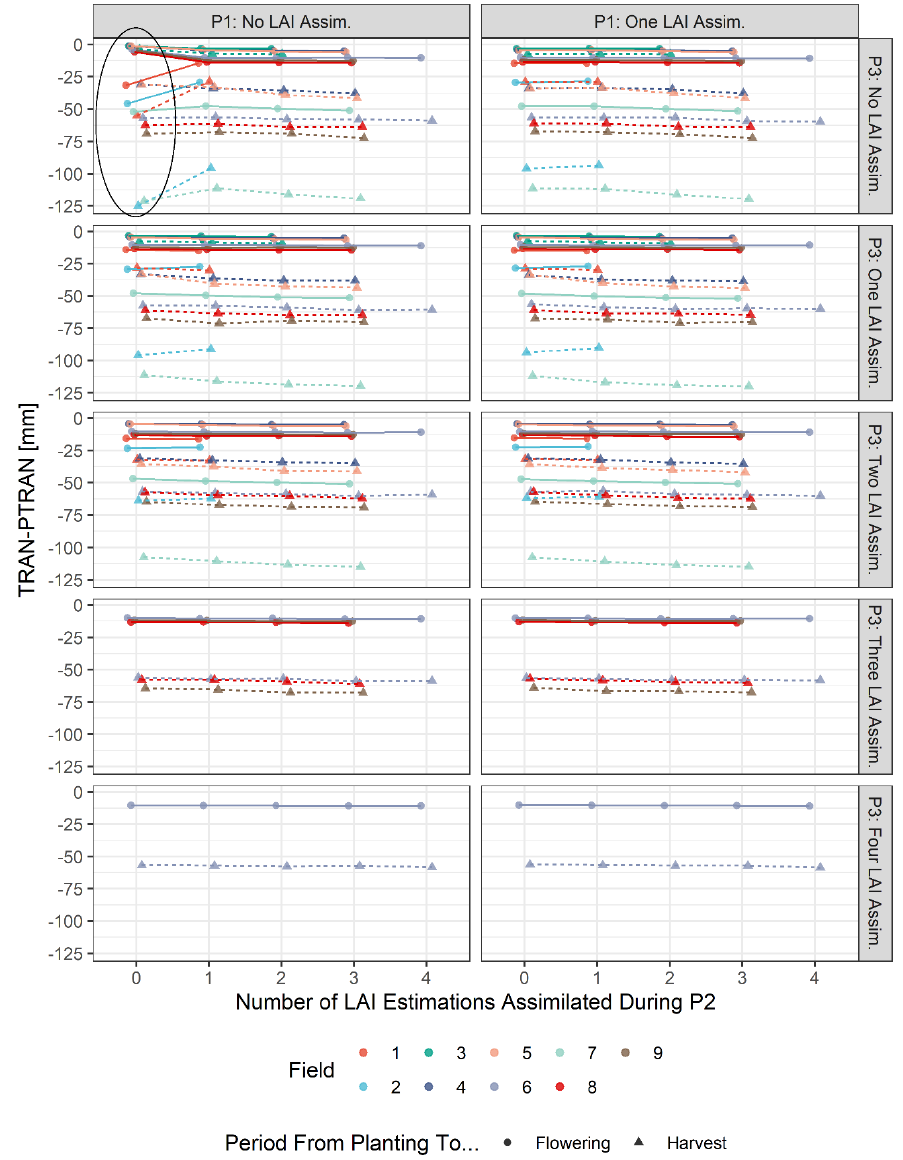
Figure 3. Difference between mean actual crop transpiration (TRAN, in mm) and potential crop transpiration (PTRAN, in mm) for Fields 1–9 as calculated by the crop model, cumulated for the period from planting to flowering and planting to harvest. Matrix of panels defined by the number of LAI estimations assimilated during phenophase 1 (P1, columns) and the number of LAI estimations